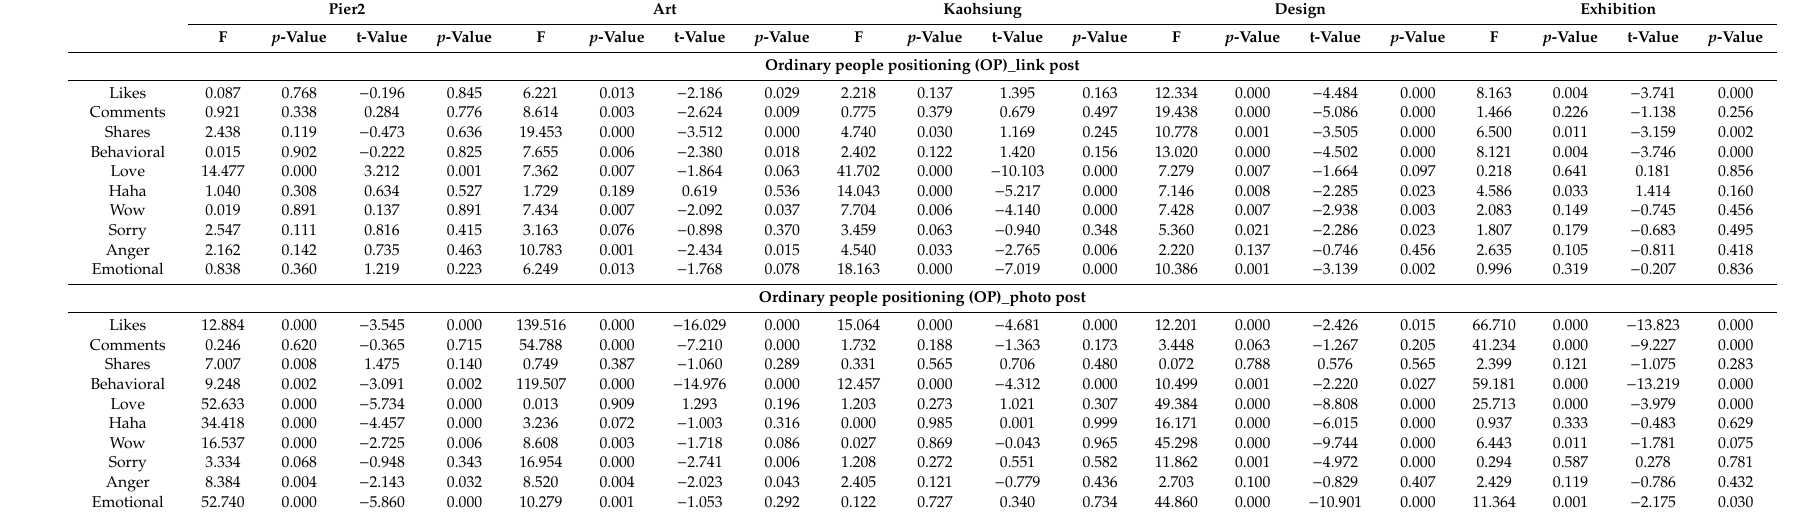
Table A3. The results of independent sample t test (ordinary people positioning (OP)).